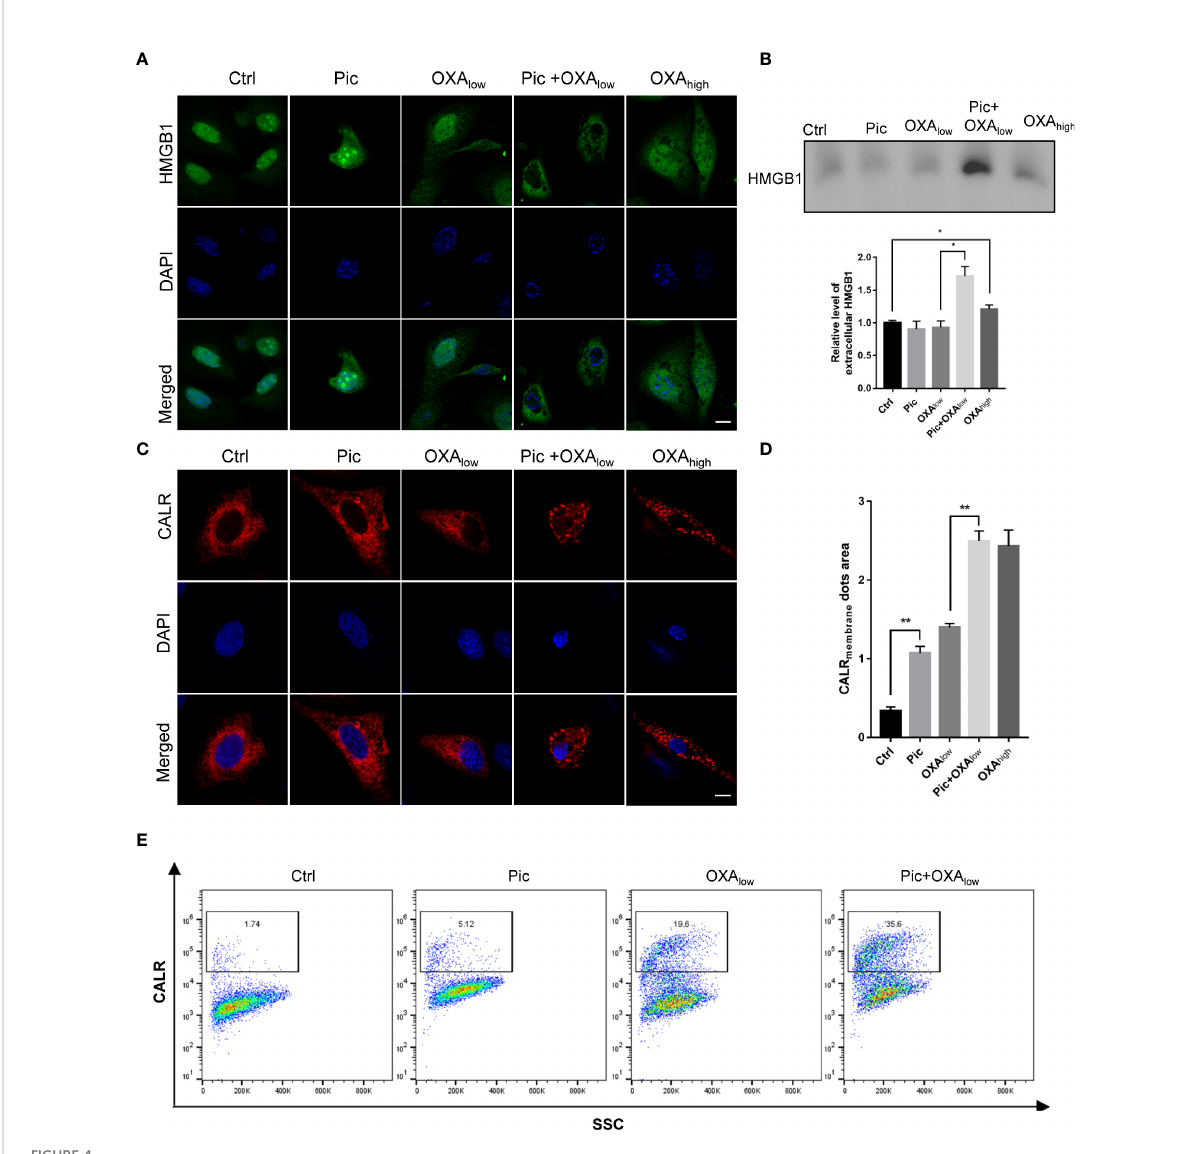
FIGURE 4 Piceatannol enhances ICD inducer OXA-induced high-mobility group box 1 (HMGB1) release and cell surface calreticulin (CALR) exposure. (A) Pic promotes OXA low -induced decrease of the nuclear HMGB1 contents. U2OS cells were treated with Pic (40 m M), OXA low (200 m M) alone or their combination (Pic+OXA low ) for 24 h, followed by detection of endogenous HMGB1 using immunostaining. OXA high (400 m M) was used as a positive control. Scale bar: 10 m m. (B) Pic plus OXA low increases extracellular HMGB1 contents as re fl ected by western blotting. The supernatant of the culture from the similar treatment as in (A) was collect for western blotting analysis of released HMGB1 and the relative level of HMGB1 for indicated treatment was quanti fi ed. (C, D) Pic plus OXA at the same concentration as in (A) increases the cell surface CALR exposure. U2OS cells transfected with CALR-RFP plasmid for 24 h were treated with Pic (40 m M), OXA low (200 m M) alone or Pic+OXA low for another 24 h before immunostaining detection (C) and the CALR membrane dots area was quanti fi ed in (D) . Scale bar: 10 m m. (E) Flow cytometry analysis further con fi rms the synergistic effect of Pic and OXA in inducing endogenous cell surface exposure. Cells treated with Pic (40 m M), OXA low (200 m M) alone or Pic+OXA low for 24 h were collected and stained with anti-CALR antibody. Data were mean ± SEM at least three replicates. Student-t test was used for statistical analysis. * p -value < 0.05, ** p -value <